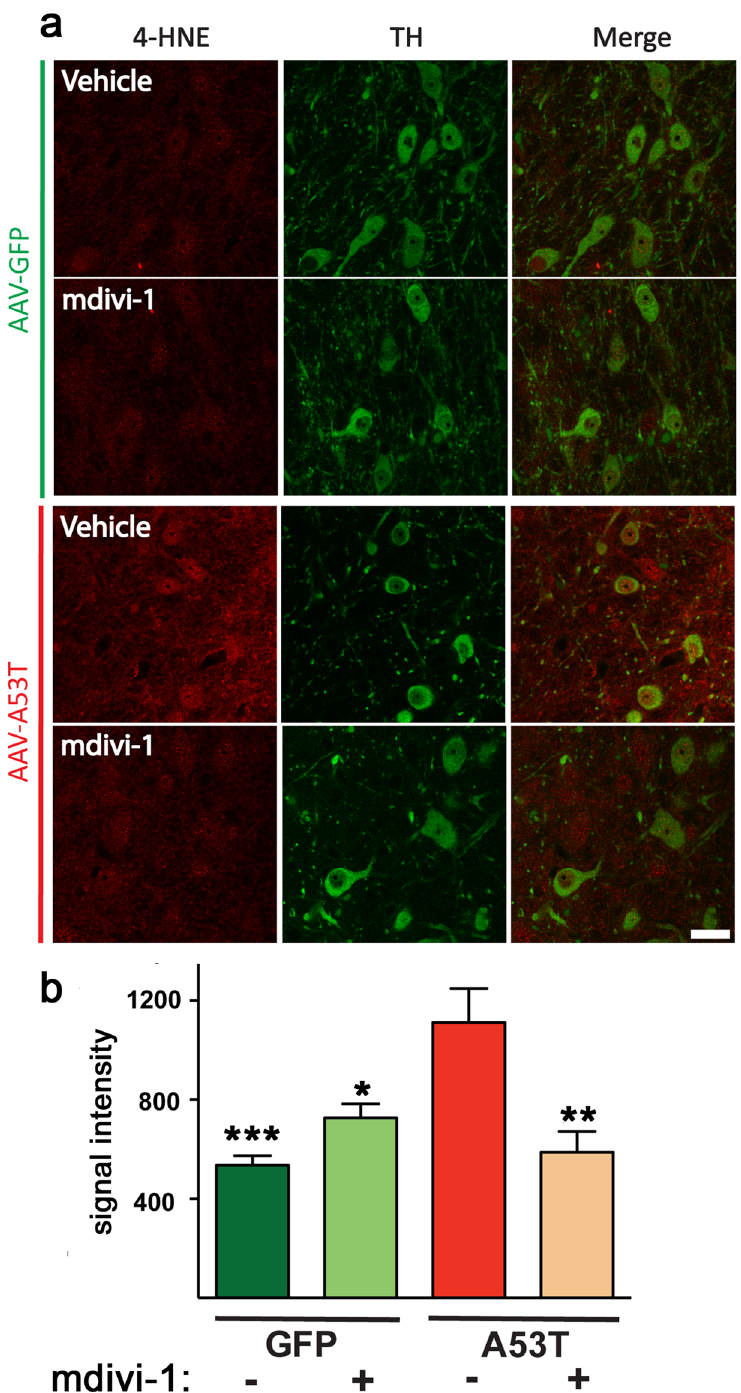
Figure 6. Mdivi-1 decreases ROS-mediated lipid oxidation in A53T animals. ( a ) Representative pictures of 4-HNE staining (red) measured in TH positive neurons (green). Scale bar 30 μ m. ( b ) Dopaminergic cells of animals expressing hA53T- α -syn display an increase of lipid oxidation that turned back to basal levels in the presence of mdivi-1 treatment. Quantification was carried out measuring the levels of grey of 4-HNE staining in 16-bit images. Fluorescent images are captured as single layer. Values are means ± SEM for 7–8 rats (6 cells are analysed for each rat) and were analysed by two-way ANOVA (AAV injection: F 1,27 = 5.196 p = 0.0308; treatment: